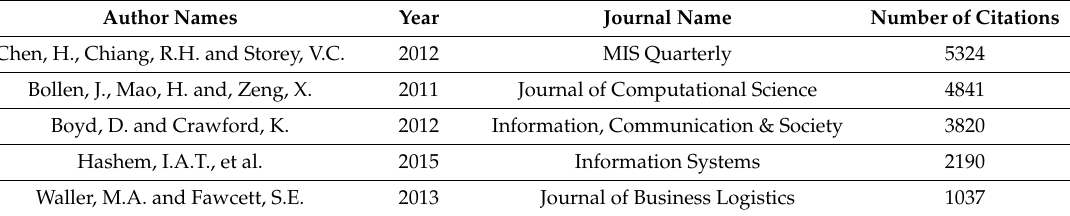
Table 5. Top five most cited